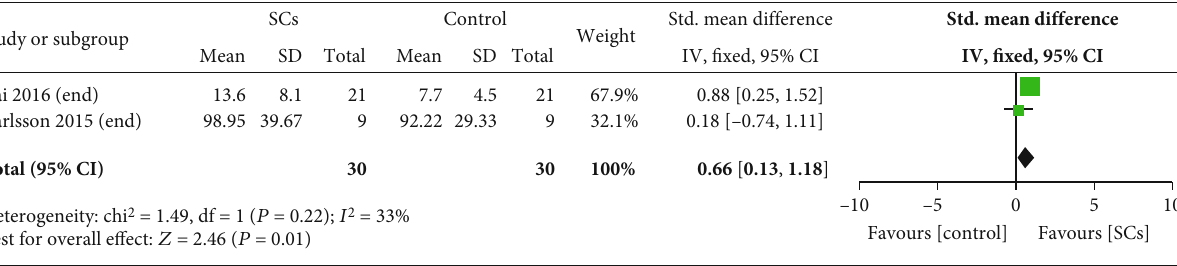
Figure 5: AUCC in experimental and control group (RCTs).